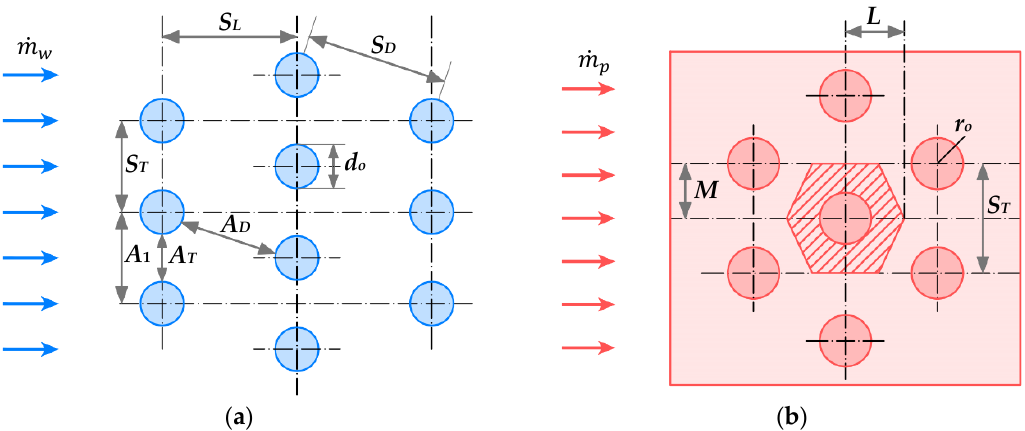
Figure 4. Schematic of a staggered GAHP bank illustrating nomenclature: ( a ) Working air wet channel; ( b ) Product air channel with continuous flat-plate fin.